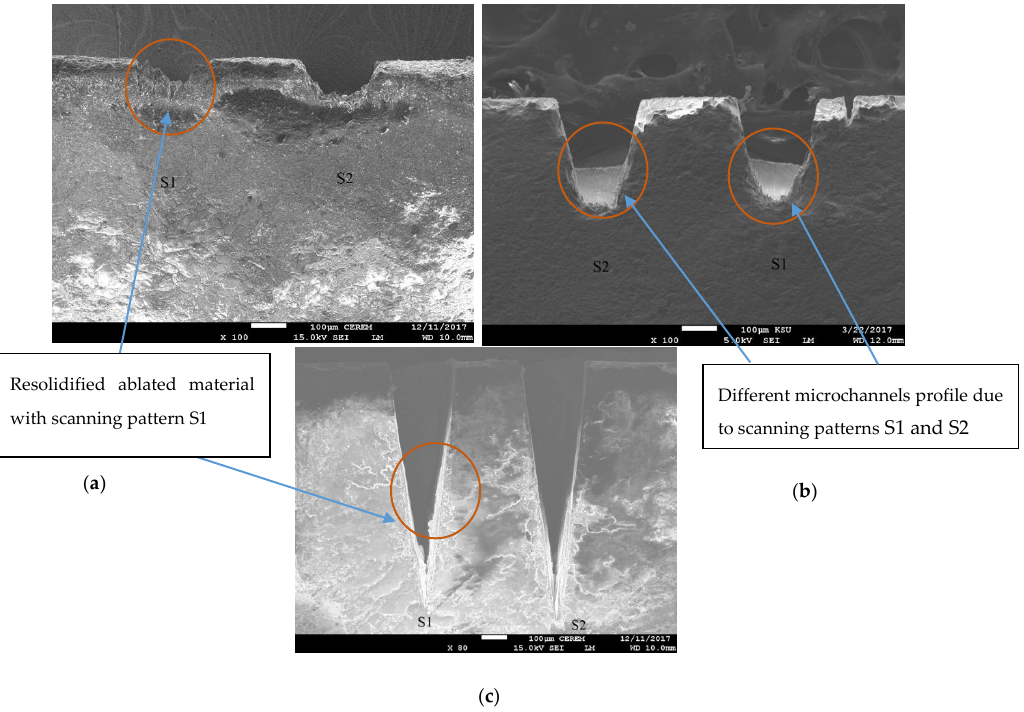
Figure 15. Microchannels with different depths using scanning pattern S1 and S2 ( a ) Low depth channels ( b ) Moderate depth channels ( c ) High depth channels.